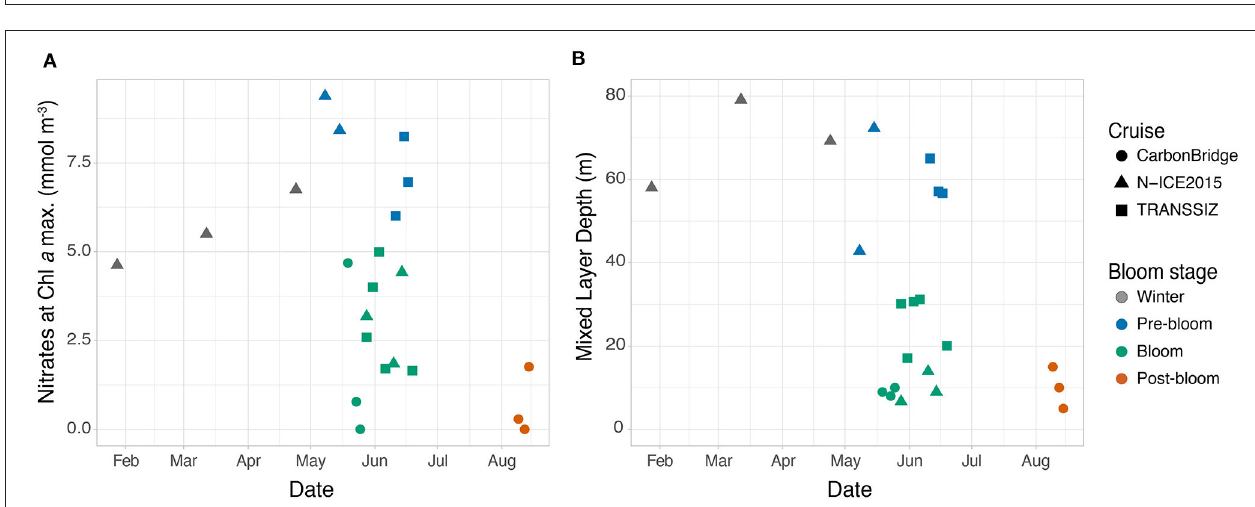
FIGURE 2 | Physical and chemical setting of all the sampling stations, sorted into winter, prebloom, bloom, and post-bloom stages. Temperature (with 2 ◦ C Atlantic water reference line), salinity, nitrates, and silicic acid concentrations are shown for the upper 100–200m of the water column.